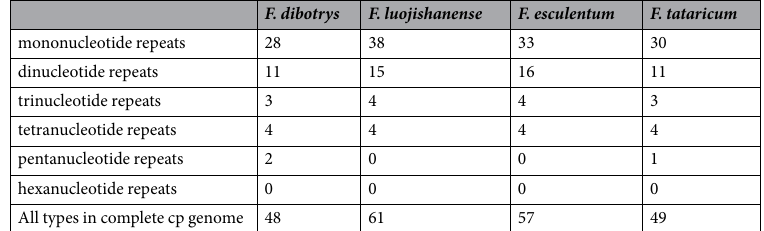
Table 4. Types and number of SSRs in chloroplast